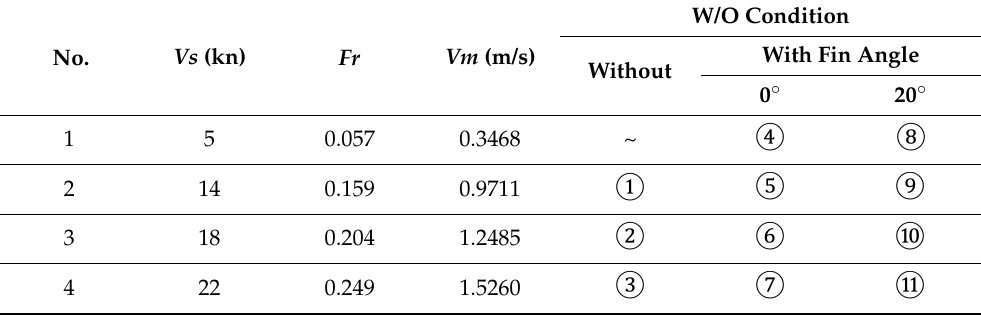
Table 2. Test cases.